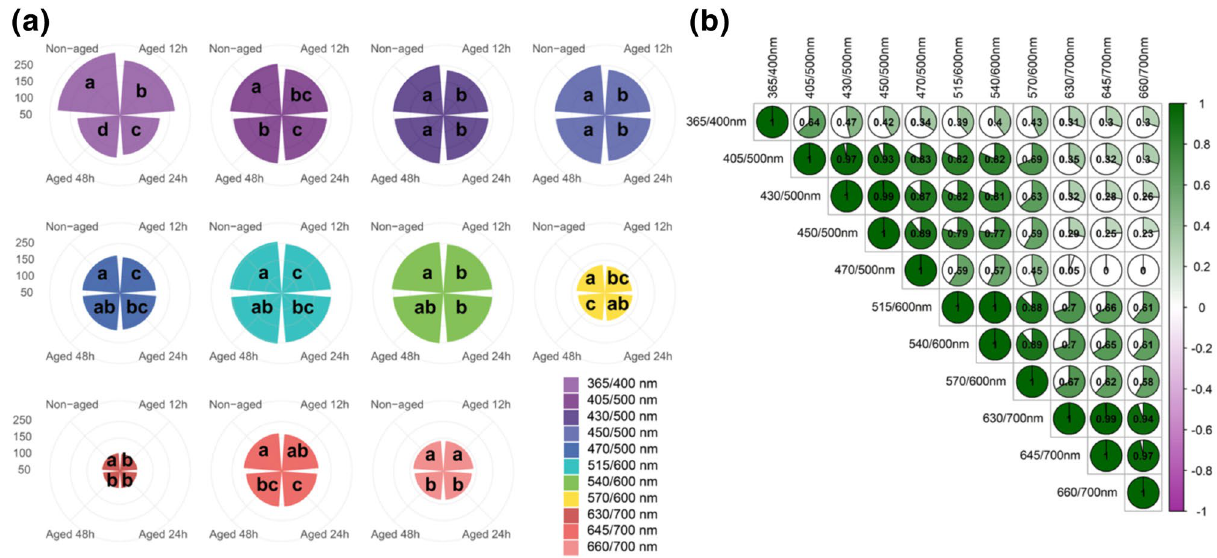
Figure 3. Comparison between classes of non-aged soybean seeds and seeds aged for 12, 24 and 48 h using autofluorescence-spectral data from different excitation-emission combinations; means followed by the same letter are not significantly different according to Tukey test ( P < 0.05) (a) . Pearson’s correlation coefficients between all bandwidths used for autofluorescence-spectral imaging of soybean seeds ( n = 200 seeds) (b)